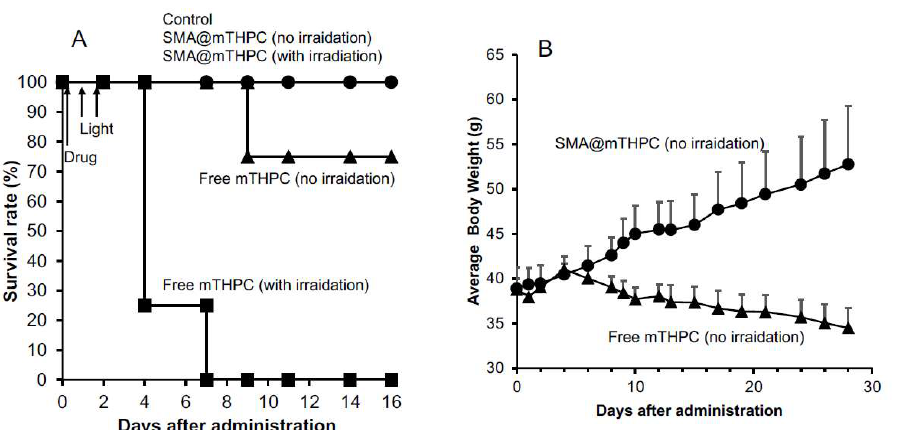
Figure 9. Toxicity profiles of SMA@mTHPC and free mTHPC as indicated by survival rate and body weight change in S180 tumor-bearing mice. ( A ) SMA@mTHPC or free mTHPC was injected i.p. at a concentration of 10 mg/kg (mTHPC equivalent), and in some mice, light irradiation was carried out as described in Figure 7, where the survival rate was recorded. In a separate study, SMA@mTHPC or free mTHPC was injected i.v. at a concentration of 20 mg/kg (mTHPC equivalent) with light irradiation, and the body weight change ( B ) was measured and calculated. Data are means ± SD; n = 4–8. See text for details.